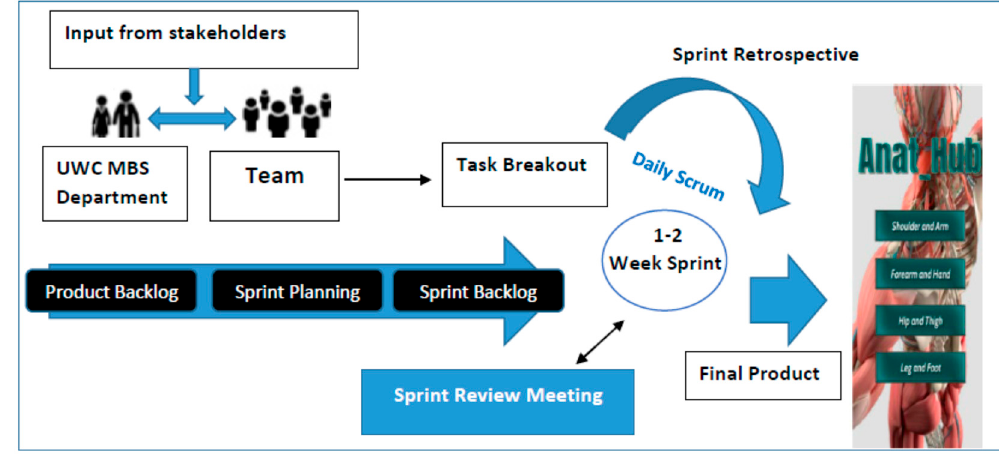
Figure 1. A simplified breakdown of the adopted agile scrum methodology.